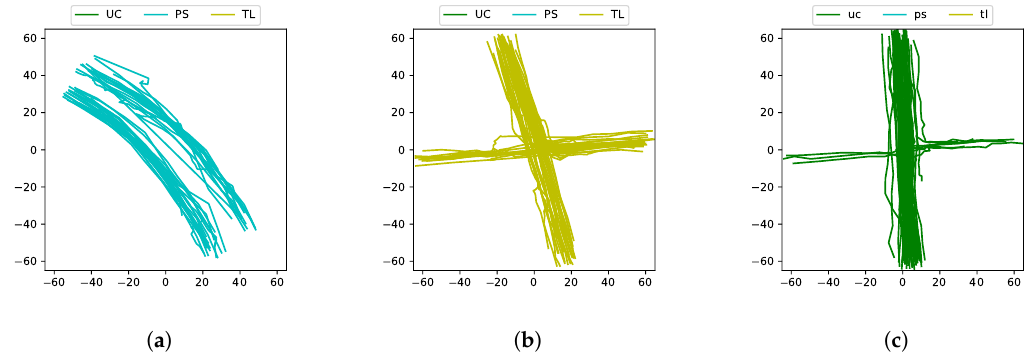
Figure 4. GPS tracks extracted from the given junction for traffic regulators such as priority-signs, traffic-lights and